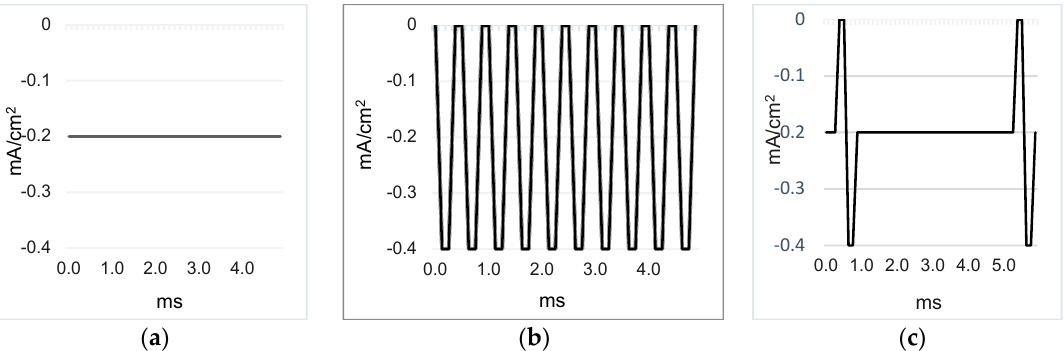
Figure 2. Negative polarity current profiles: ( a ) galvanic direct current (DC); ( b ) square unipolar pulse current (SPC); ( c ) galvanic direct current and pulse current (DC + PC).